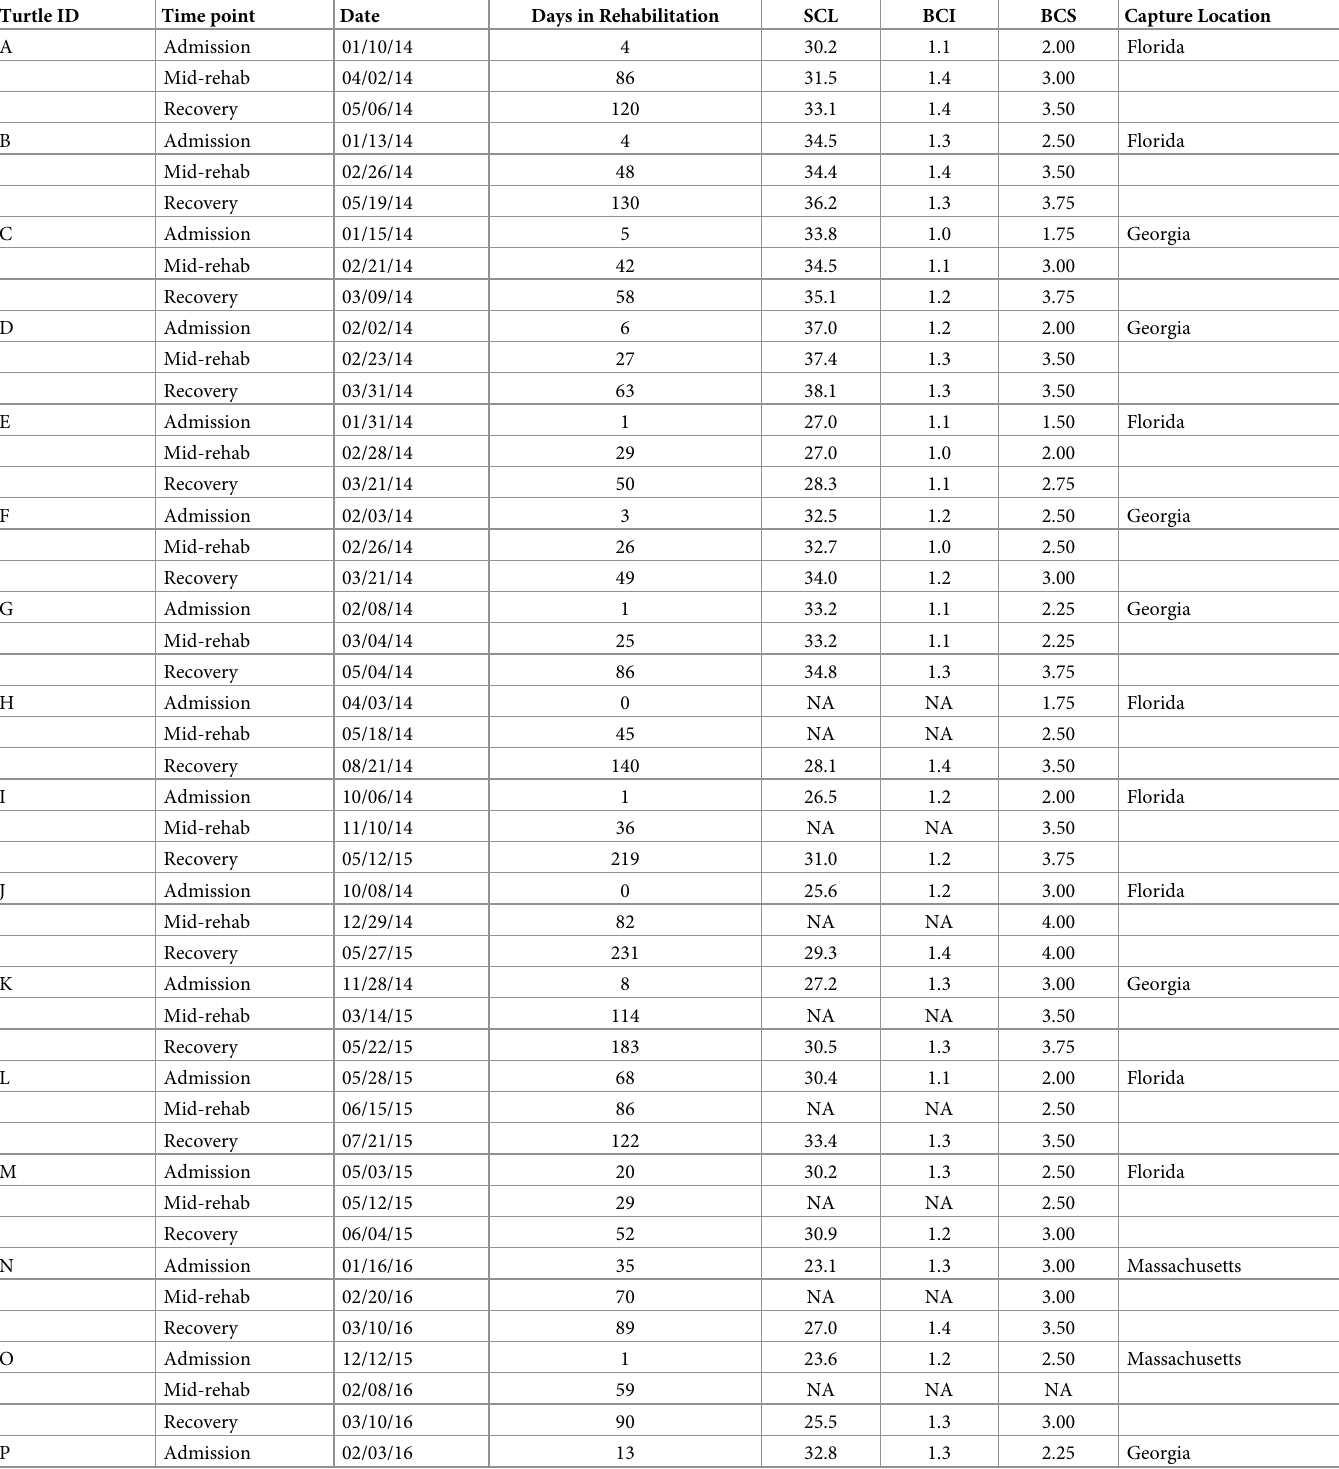
Table 1. History and physical exam data for green turtles in rehabilitation at the Georgia Sea Turtle Center at the three timepoints of fecal collection for metage- nomic analysis (admission, mid-rehabilitation, and recovery) a . Turtle